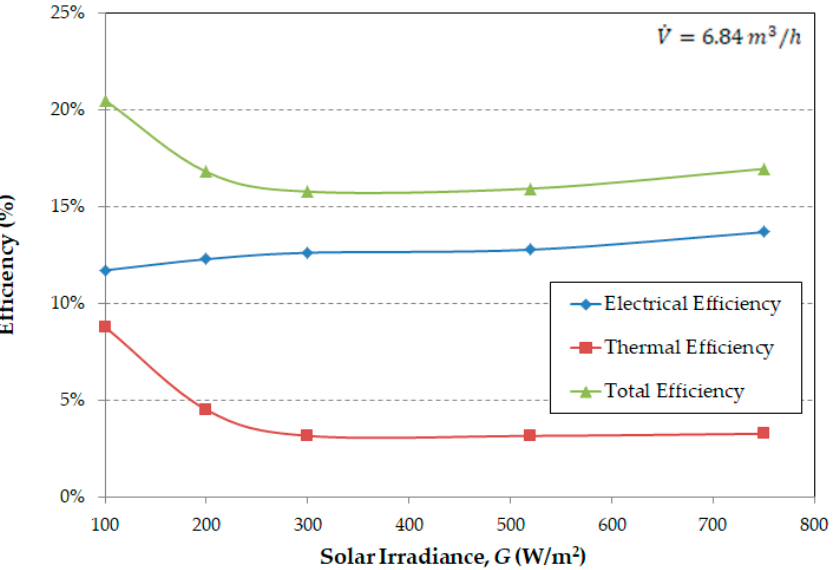
Figure 8. Efficiency changes depending on solar irradiance for a modified PV module, cooled by fans with the intensity of airflow at 𝑉(cid:4662) = 6.84 (cid:2923)